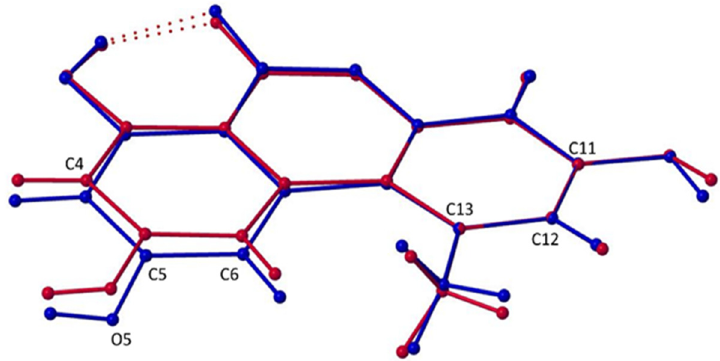
Figure 4. Overlayed wireframe images of alternariol Form I (blue) and Form II (red) matching C11, C12, and C13 of each structure.